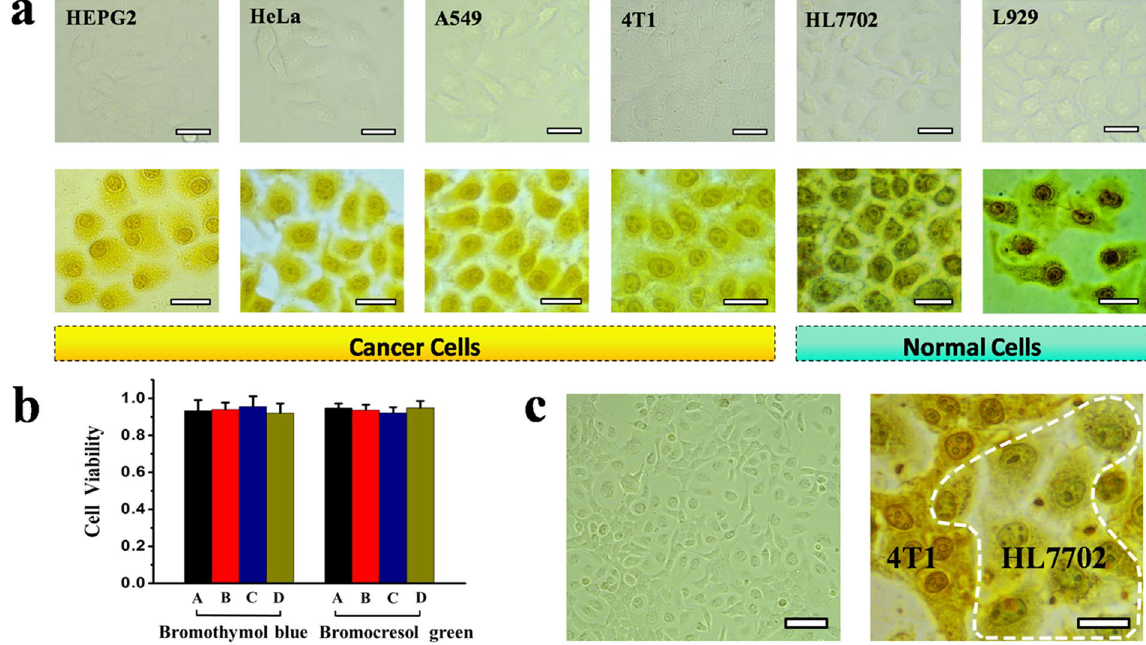
Figure 2. Visual identification and screening of cancer cells from normal cells and cytotoxicity assays. ( a ) Bright-field optical microscope images of cancerous HepG2, HeLa, A549, 4T1, normal HL7702 and L929 cells before and after 5 min incubation with 1 mg mL − 1 of bromothymol blue, respectively; All scale bars: 20 μ m. ( b ) Cytotoxicity assays for the A549, HeLa, HL7702, and L929 cells after the incubation with bromothymol blue or bromocresol green. A, B, C, D under the X-coordinate represent A549, HeLa, HL7702, and L929 cells, respectively. ( c ) Bright-field microscopy images of cocultured cancerous 4T1 and normal HL7702 cells before (left, scale bar: 50 μ m) and after (right, scale bar: 15 μ m) the treatment with bromocresol green. The cells within the white dotted line are identified as HL7702